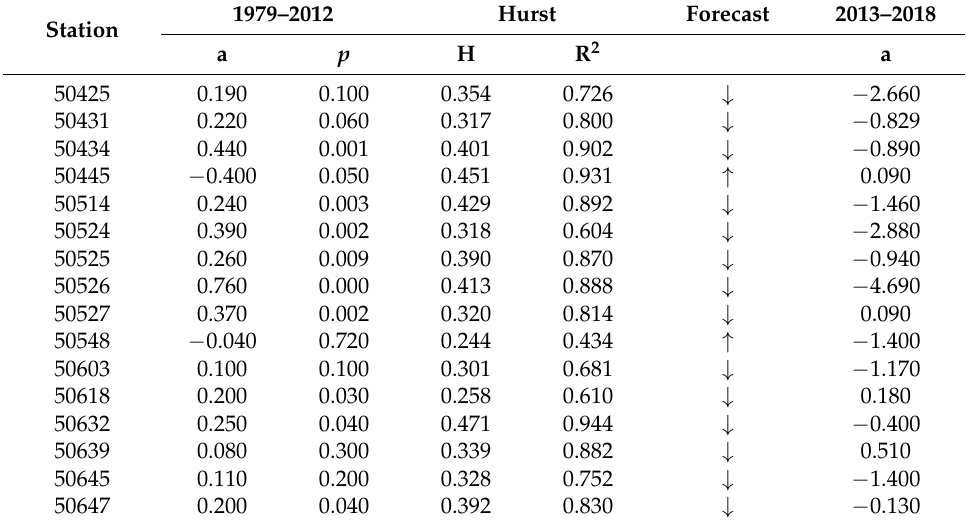
Table 4. Trends and Hurst exponents of snow depth over the period of 1979–2012 and the forecasts and trends in snow depth over the period of